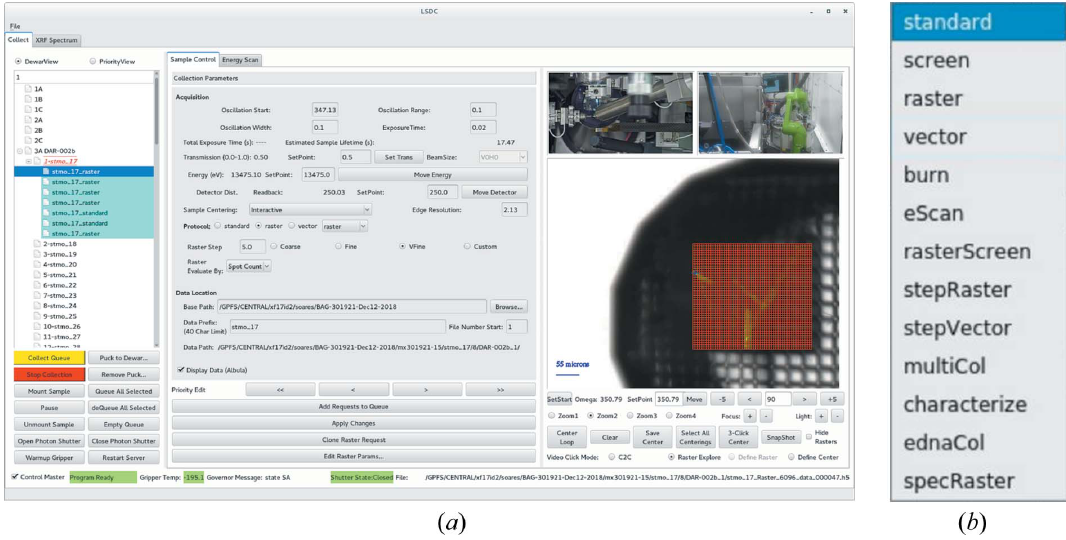
Figure 6 ( a ) The samples/requests view is displayed in the left column, data acquisition parameters including access to all protocols are set in the center, and the sample video view including centering modes and interactive feedback of the raster heat map is displayed in the right column. Two of the pan zoom tilt (PZT) camera views are also displayed in the GUI so that users have a good overview of what is happening in real time at the beamline. ( b ) The drop- down menu of the currently available